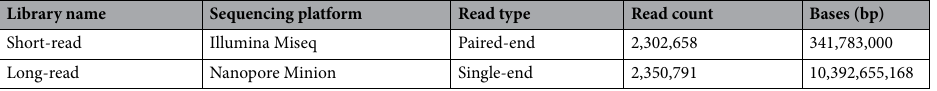
Table 1. Summary of generated sequencing data for E. coli genome used in this study.